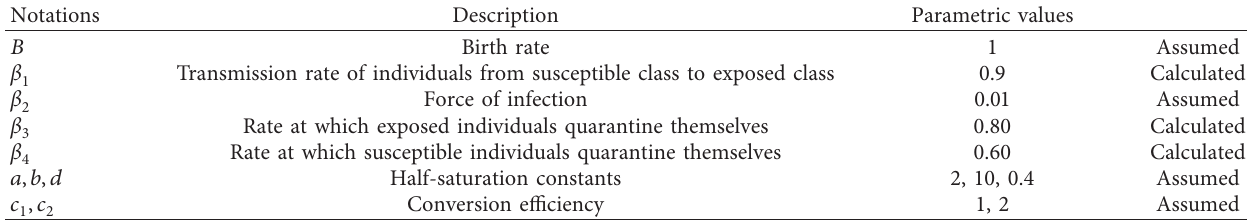
Table 1: Parametric definitions and their values.